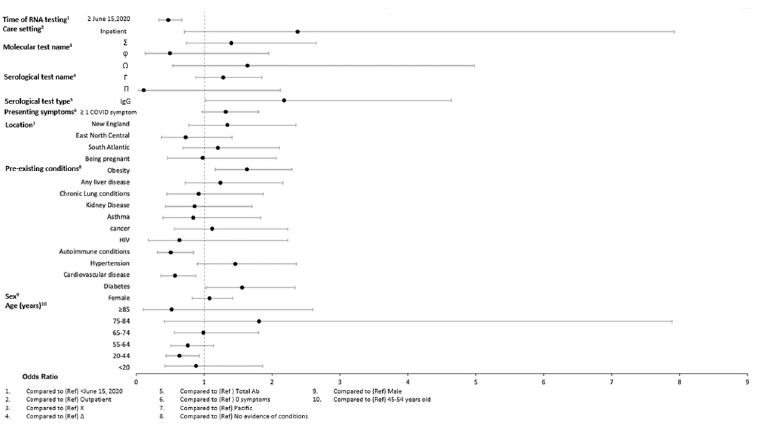
Fig 4. Odds of seropositivity dataset